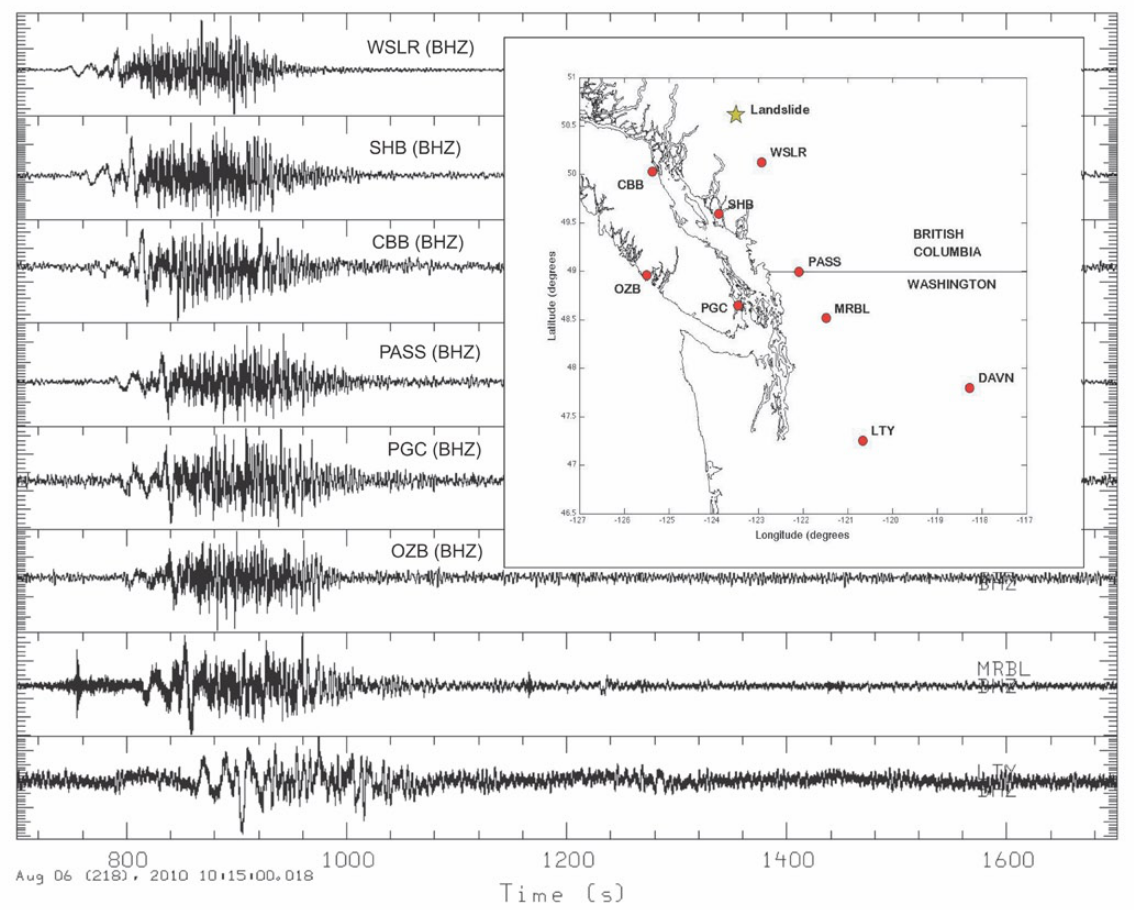
Fig. 7. Raw seismic signals from Mount Meager landslide recorded across southwestern Canada and northern Washington State (CNSN and PNSN data). Station and landslide location indicated on inset